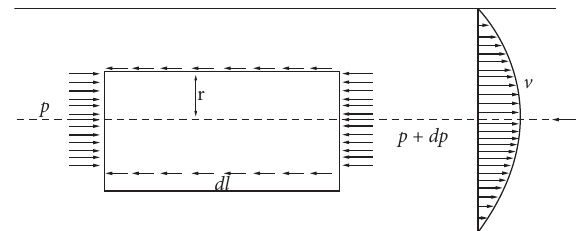
Figure 1: Flow diagram of Newton fluid of time-dependent be- havior in the circular